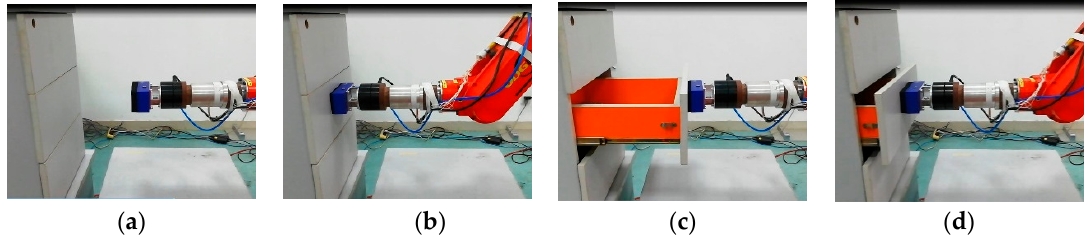
Figure 24. Human-robot cooperate to finish drawer switch experiment: ( a ) approach to the target; ( b ) grab the target; ( c ) open switch ( d ) close switch.